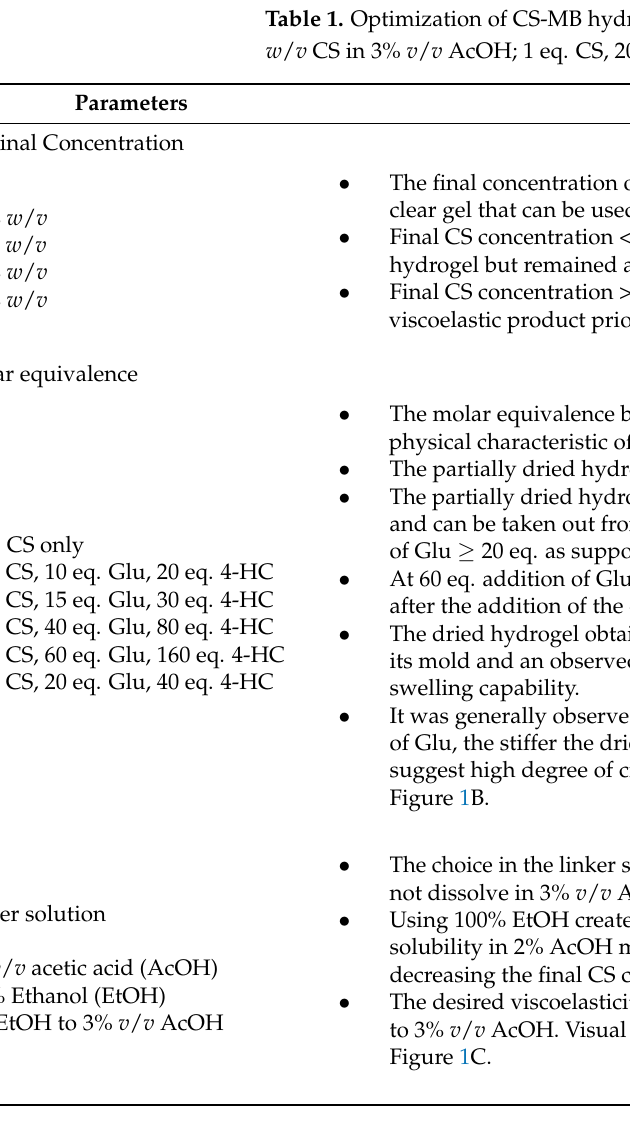
Table 1. Optimization of CS-MB hydrogel fabrication. Basis conditions unless otherwise noted: